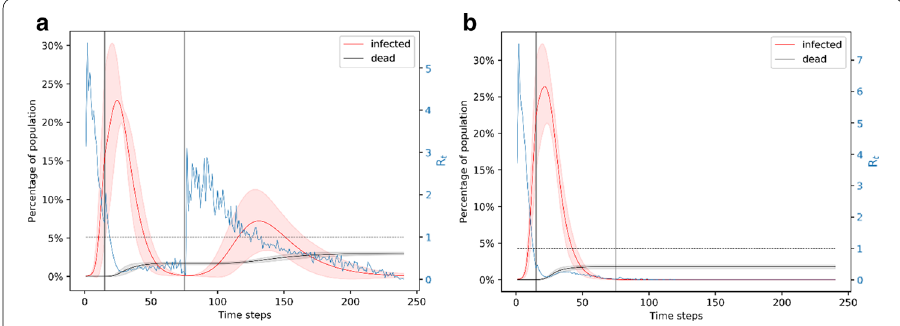
Fig. 7 Simulation of the 60-day lockdown from day 15 to day 75. a Representation of the ~ 16% of simulations that have two waves of infection for the day 15 to day 75 lockdown. The peak in the reproduction number after day 75 foreshadows a second wave of infection. Comparing with Figs. 5 and 6, we note that the second wave of infection is less intense when the lockdown starts later. b Representation of the ~ 58% of simulations that have only one wave of infection for the day 15 to day 75